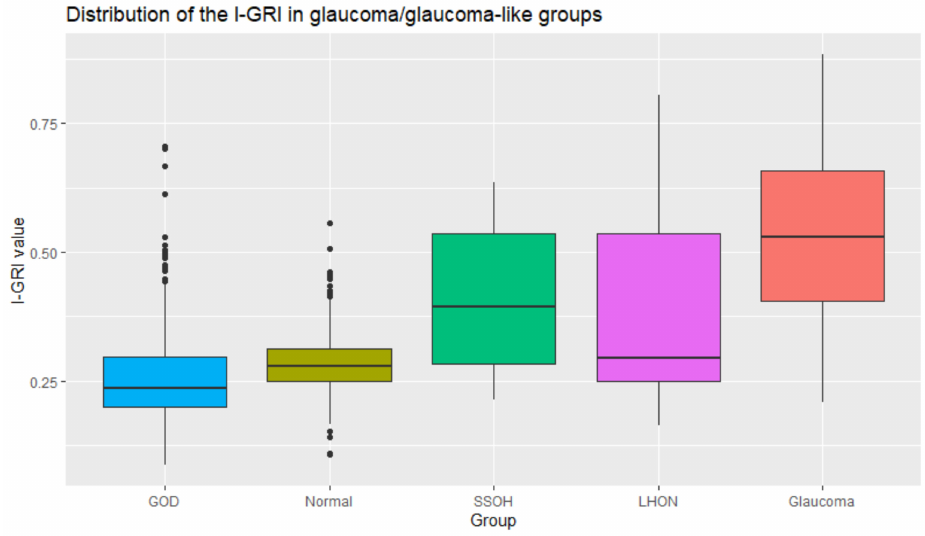
Figure 11. Distribution of the I-GRI values in the glaucoma and glaucoma-like